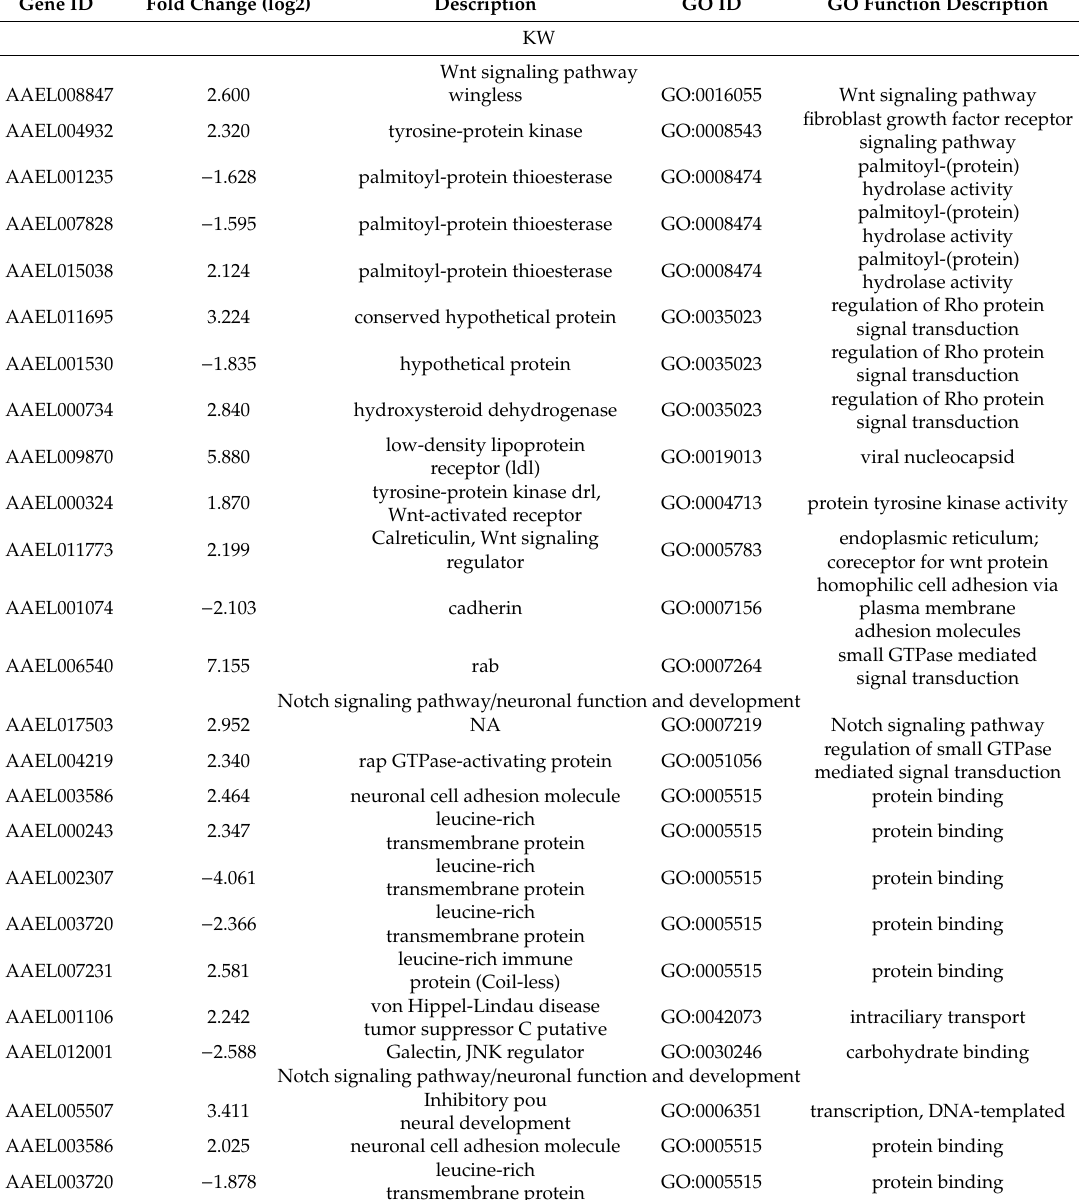
Table 6. Components of Wnt pathway and Notch pathway / neuronal development genes that are di ff erentially expressed in two field populations compared to ROCK population four days after CHIKV